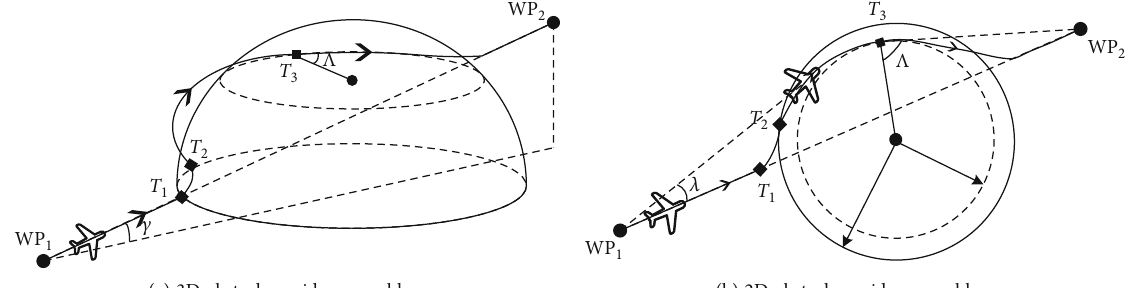
Figure 6: UAV obstacle avoidance with CTGA.